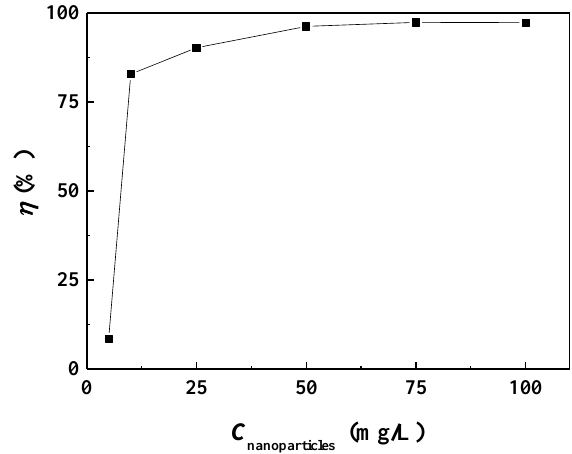
Figure 3. The surface scale inhibition efficiency of carbon nanoparticles at different concentrations.